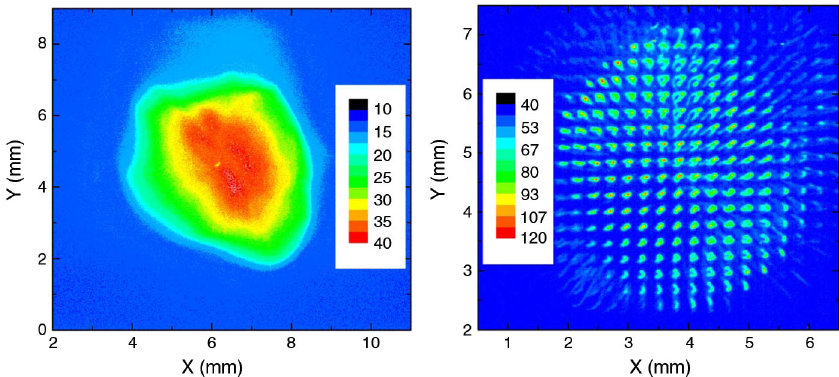
¼ 1 : 25 þ = (cid:1) 0 : 2 (cid:1) m (right); (cid:5) mc 2 ¼ n;x ¼ 3 ps , Gaussian time profile; D ¼ 1 : 8 mm . t; laser laser